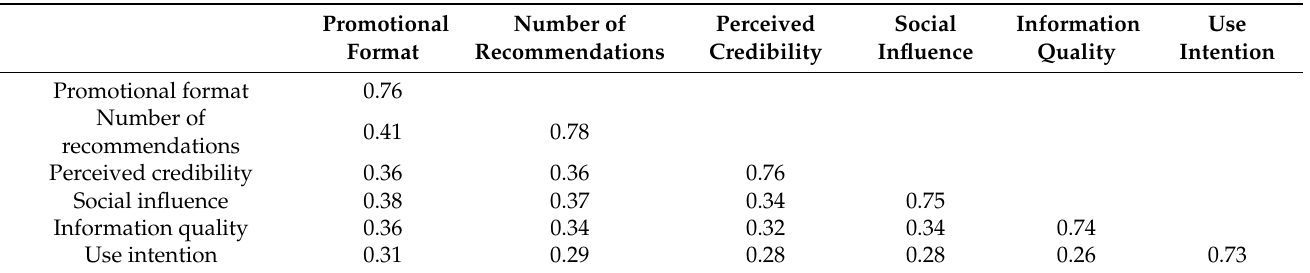
Table 4. Correlation matrix of